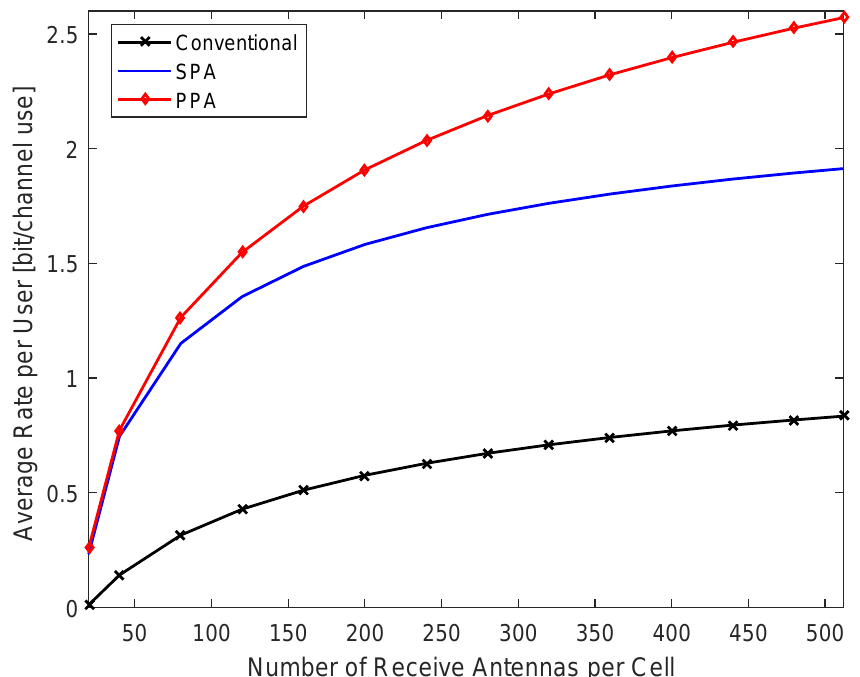
Figure 13. Average SINR per user for various number of antenna elements using ZF, assuming severe